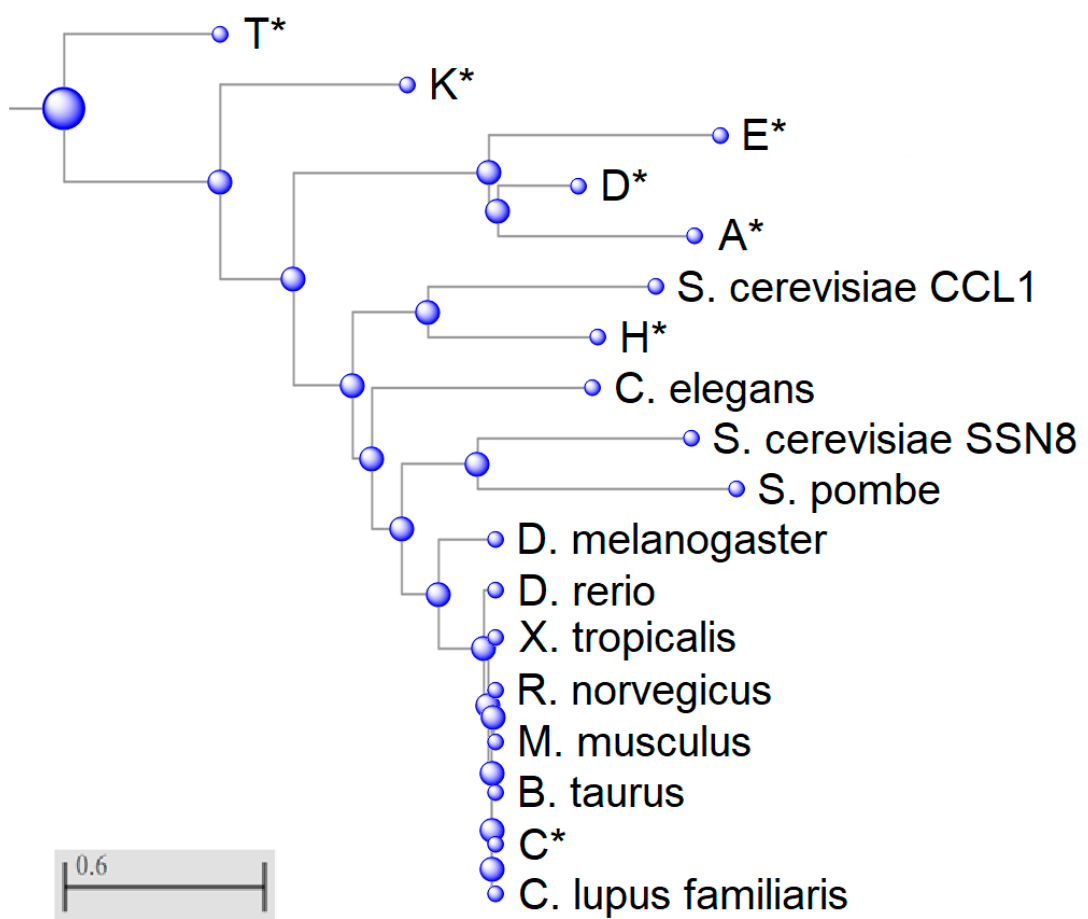
Figure 2. Phylogenetic analysis of eukaryotic cyclin sequences. Phylogenetic tree was generated using Basic Local Alignment Search Tool (BLAST). Members of the human cyclin family are indicated with an asterisk. All other sequences are cyclin C orthologs. CCL1 is a yeast cyclin H paralog. S. cerevisiae Ume3/Srb11/Ssn8 and S. pombe cyclin C homologs are the most highly conserved cyclins within this multiple sequence alignment. Scale bar indicates number of amino acid substitutions per